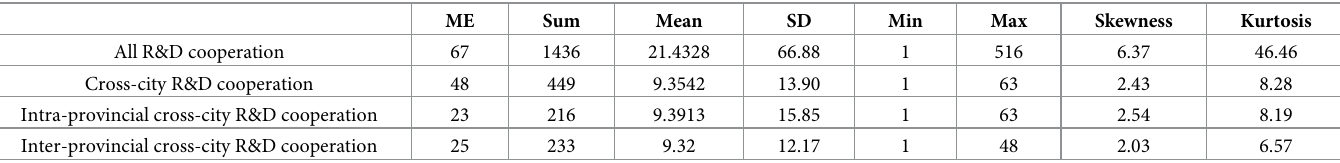
Table 4. Descriptive statistics of the Yangtze River Delta 2014–2016.